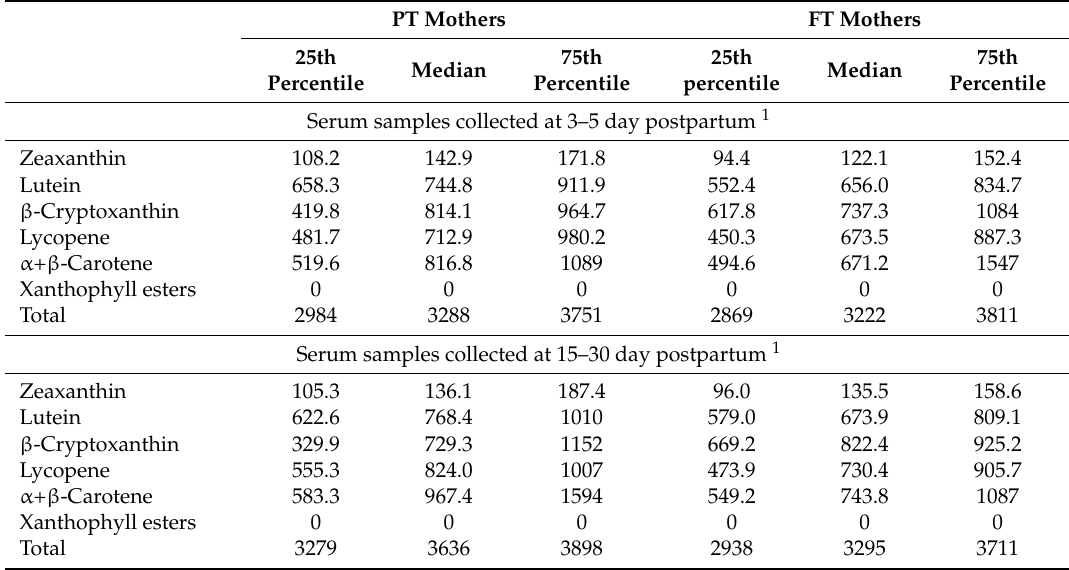
Table 2. Carotenoid content in serum of preterm (PT, n = 70) and full-term (FT, n = 70) mothers at two lactation stages. Data are expressed in nM concentration.